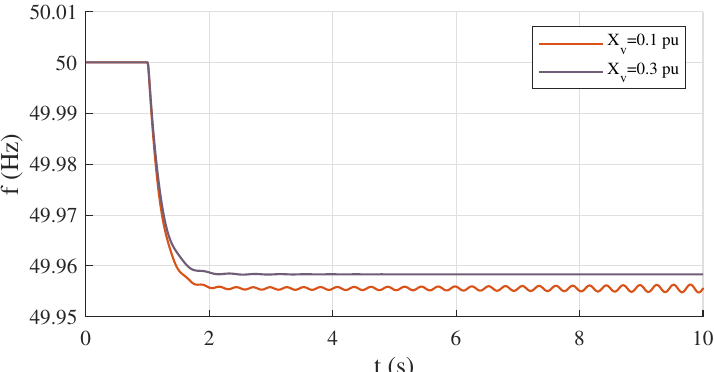
Figure 12. Impact of virtual impedance in grid-forming